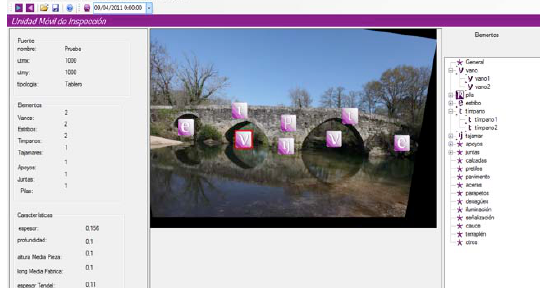
Figure 6. Main menu of the masonry BMS after rectifying and referecing all the structural elements that must be inspected.